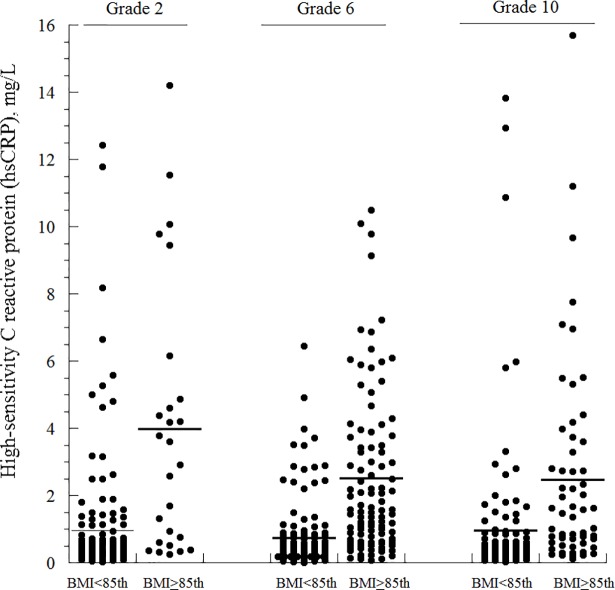
Dot plots of representative biomarkers (hs-CRP, HDL, and GGT) in the studied children as functions of grade and IOTF-BMI (<85th centile versus ≥85th centile).Horizontal lines are mean. One student (grade 10, BMI >85th centile) with a GGT value of 188 U/L is not shown in the plot.